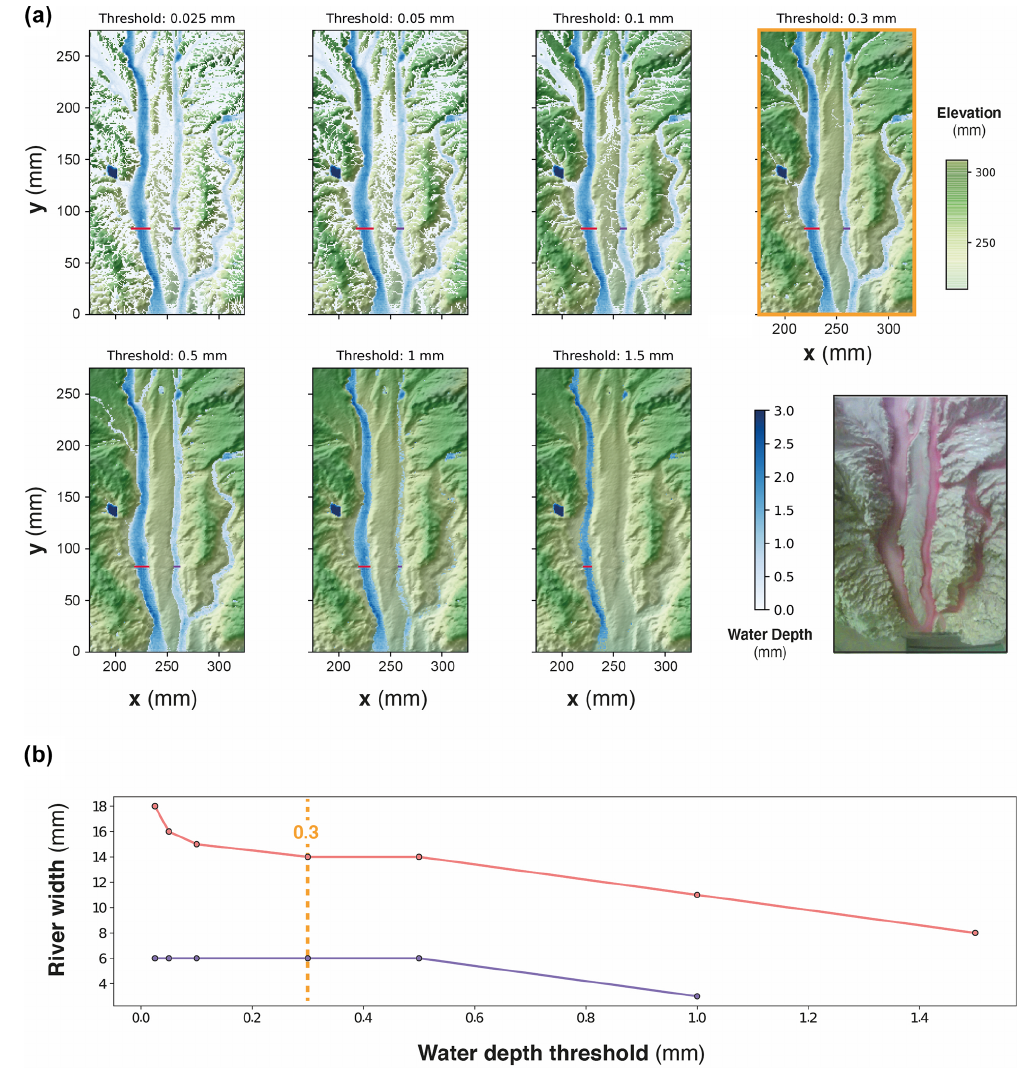
Figure 3. Impact of water depth threshold used to delineate river boundaries on estimated river widths. (a) Map views of water depths (blue colors) superimposed on DEM, for water depth threshold values between 0.025 and 1.5mm. Red and purple lines show corresponding river widths for two rivers. Photo on the bottom right shows the active river width during the corresponding experimental run (“control run”), viewed by injecting red dye into the water used to generate the artificial rainfall. (b) Corresponding local river widths for the two sections shown by red and purple lines. A threshold value of between 0.1 and 0.5mm shows a good similarity between rivers on water depth map and the control run. Here, a mid-value of 0.3mm has been chosen for computing river